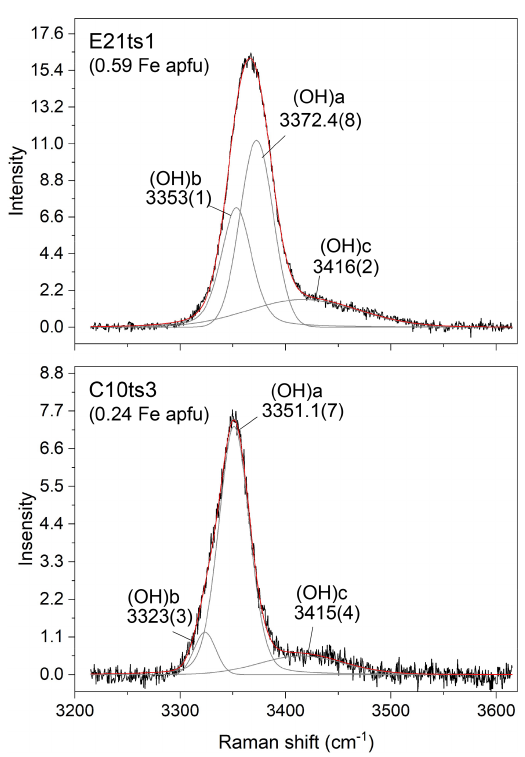
Figure 6. Raman spectra E21ts1 and C10ts3 in the OH-stretching region.